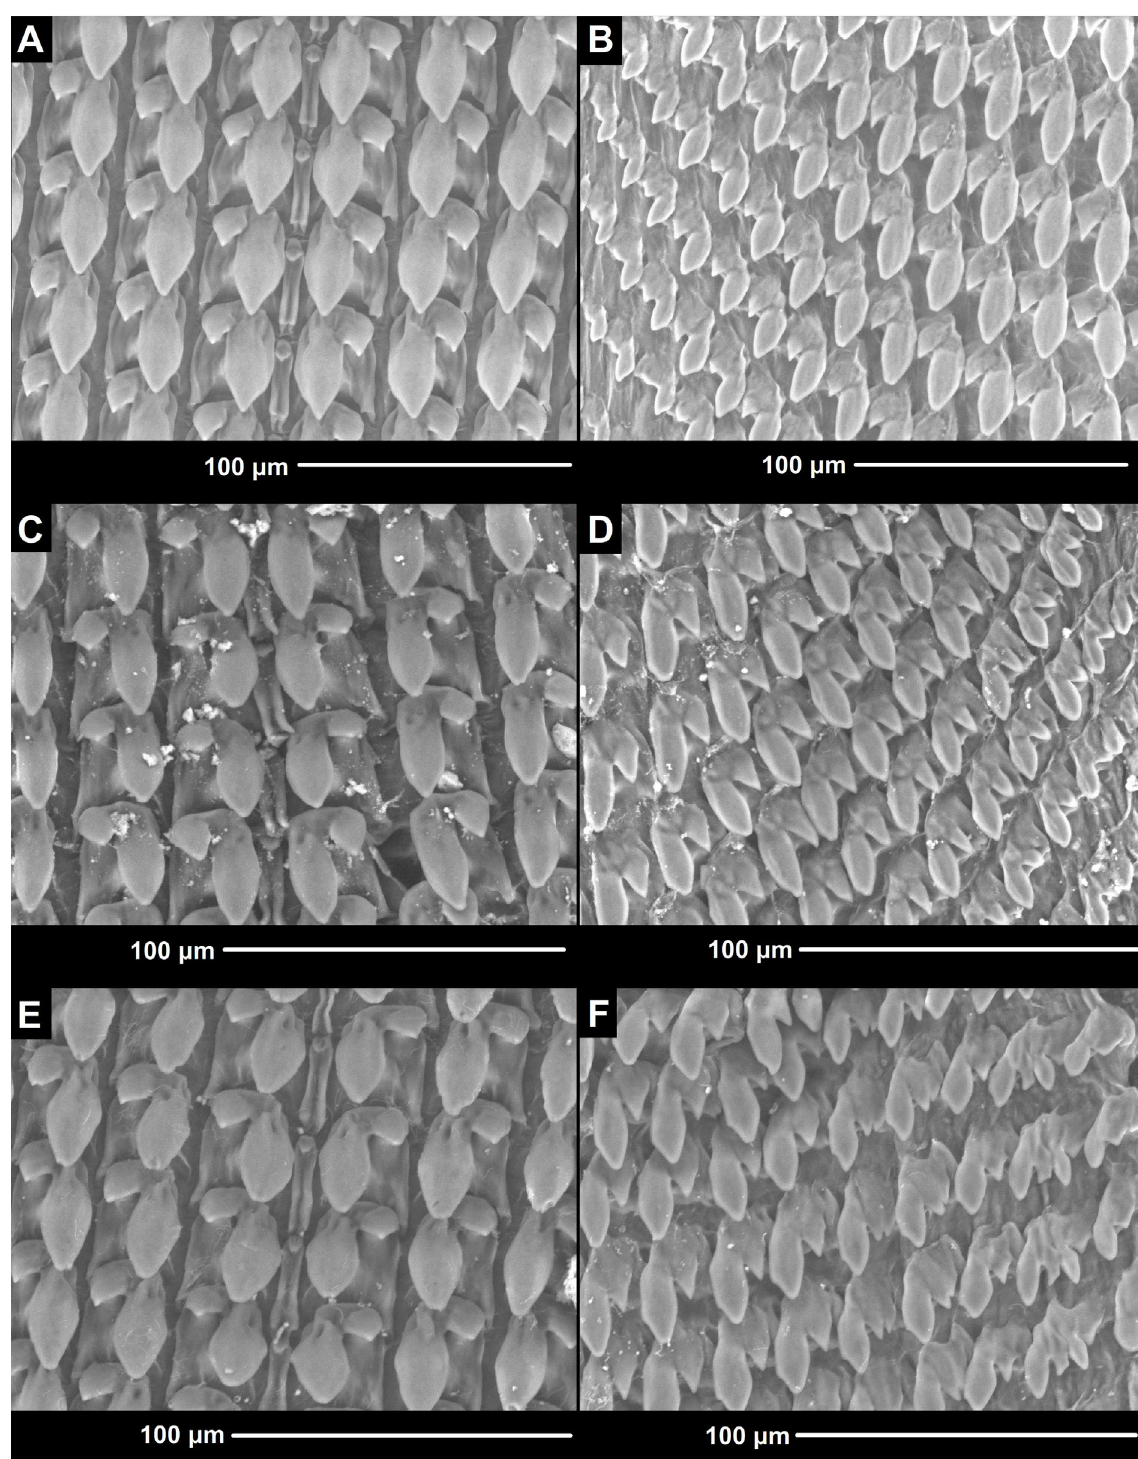
Fig. 38. Radula of species of Plectopylis Benson, 1860. A, C and E show central and first lateral teeth; B, D and F show marginal teeth. A–B . P. bensoni Gude, 1914. C–D . P. cairnsi Gude, 1898 (UF 76467). E–F . P. crassilabris sp. nov. (UF 343899). All images: B.